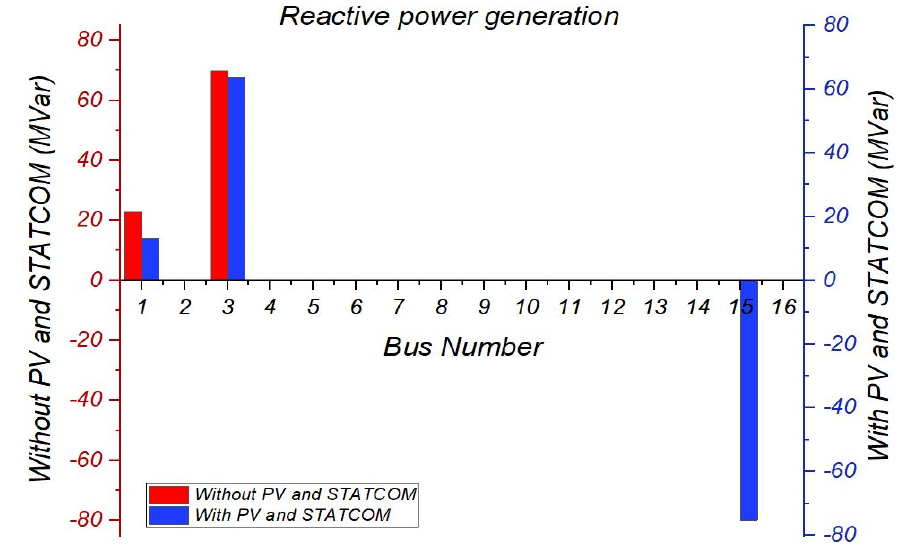
Figure 25. Reactive power generation without and with SPVGP and STATCOM.